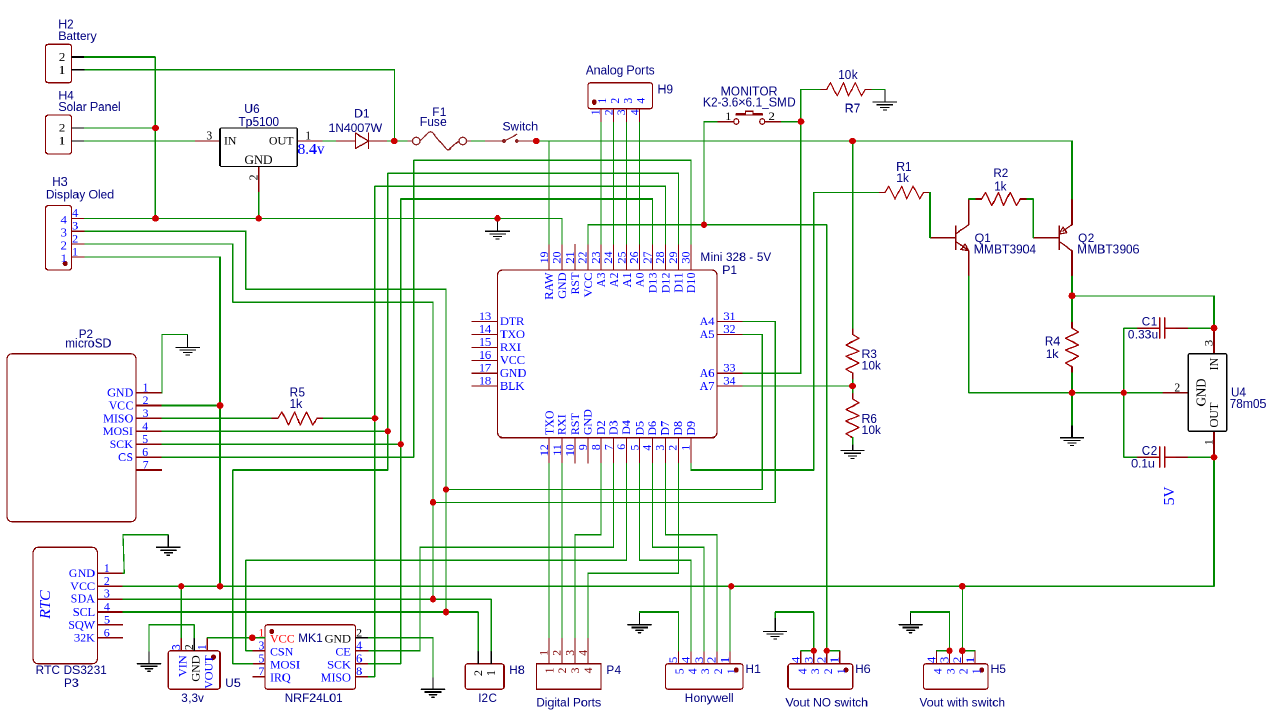
Figure A1. Schematic diagram showing connectivity between different components of the IoT device.